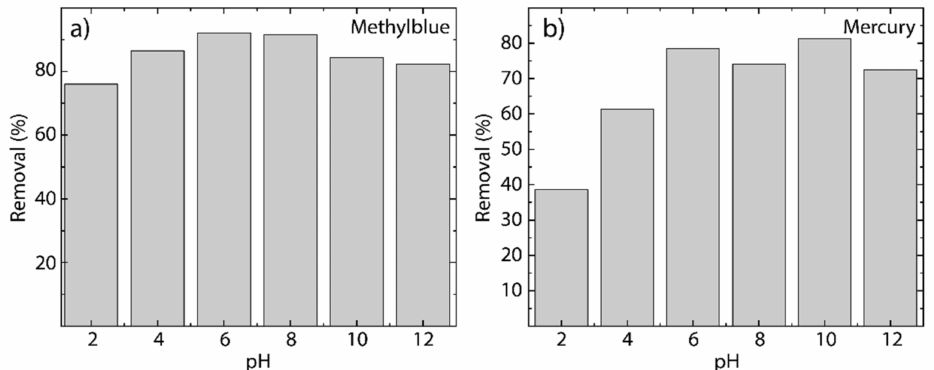
Figure 9. Removal percentage as a function of the pH (from 2 to 12) at 298 K of ( a ) MB on rGO and ( b ) Hg(II) on rGO (MB concentration 100 mg L − 1 and Hg(II) concentration 100 mg L − 1